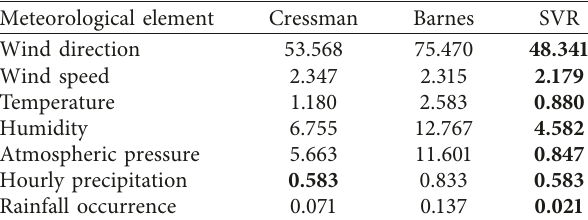
Table 10: Comparison of estimation accuracy based on estimation model (RMSE).